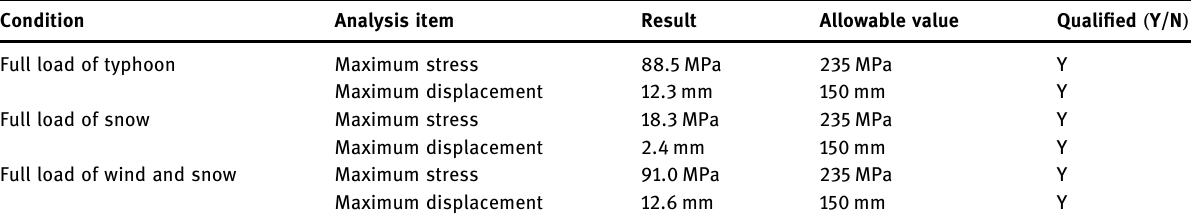
Table 3: Steady - state mechanical analysis results of smart light poles Condition